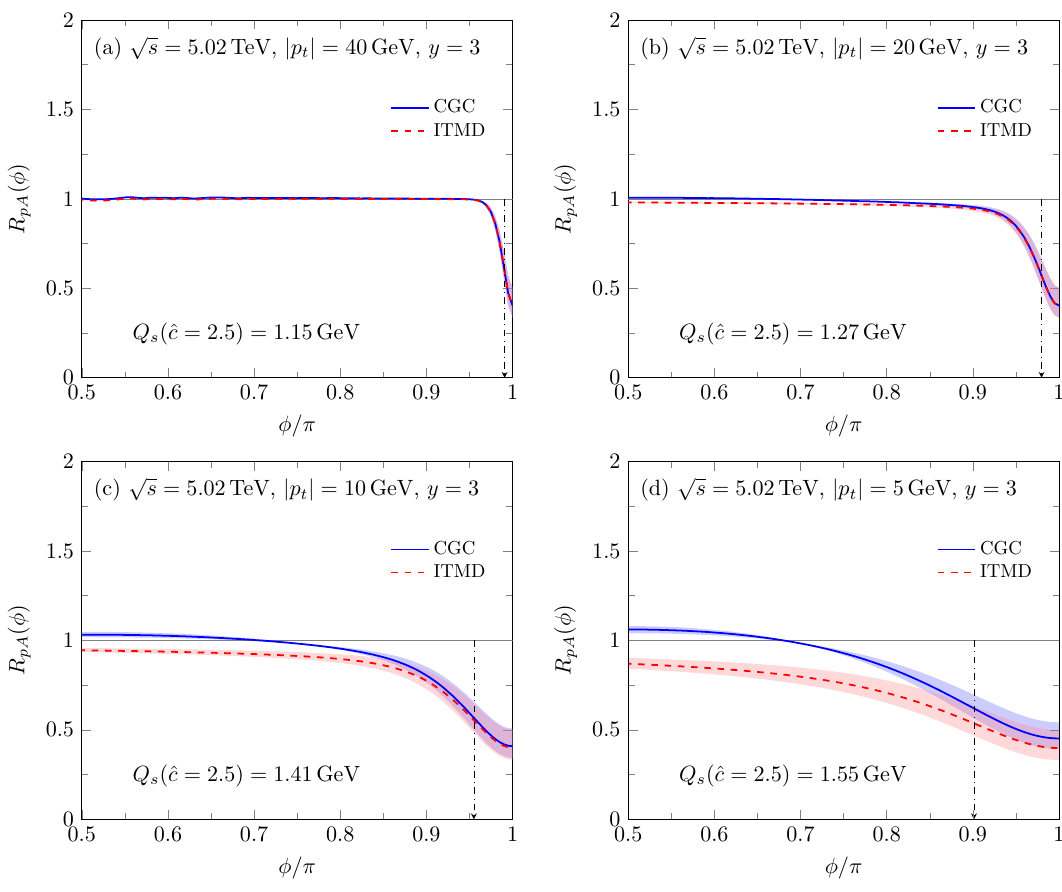
Figure 10 . Nuclear modification factor as a function of φ for forward dijet production of | p t | = √ 40 GeV (a), 20 GeV (b), 10 GeV (c), and 5 GeV (d) at s = 5 . 02 TeV. Colored bands show the uncertainty of the initial saturation scale for the target nucleus: ˆ c = 2 – 3 . The vertical arrow line in each plot indicates the deviation δφ = Q s / | p t | from the correlation limit φ = π